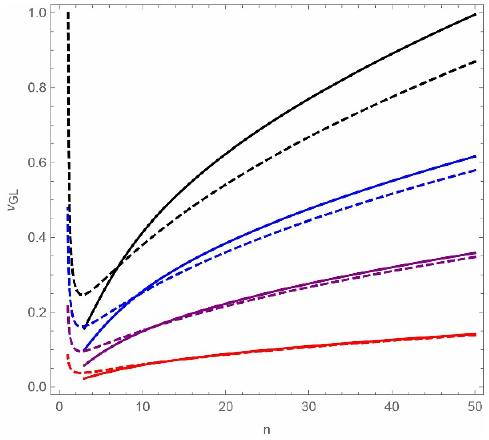
Figure 7 . Onset of the Gregory-La(cid:13)amme instability (cid:23) GL for black rings as a function of n for m = 8 (black lines), m = 12 (blue lines), m = 20 (purple lines) and m = 50 (red lines) using (cid:12)rst order blackfold approach (dashed lines) and second order blackfold approach (solid